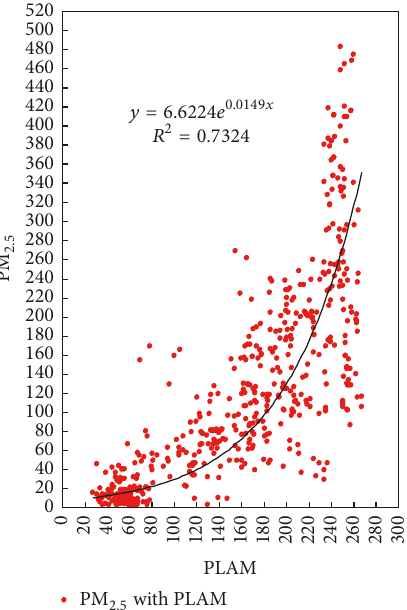
Figure 5: Analysis on correlation of hourly PM 2.5 measurements in Beijingintheperiodof1–31December2016withPLAMindexunder meteorological